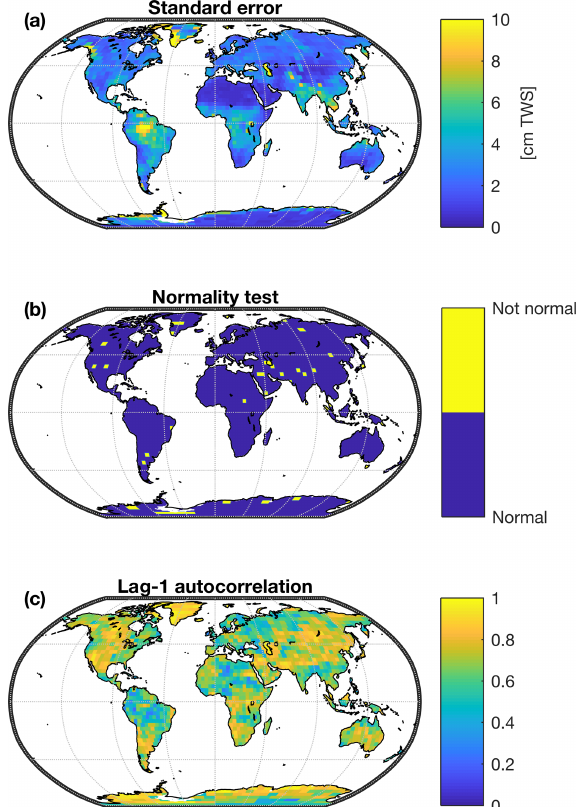
Figure 2. Characterization of the empirical model residuals for the GRACE-REC dataset based on MSWEP precipitation and ERA5 air temperature, calibrated with the JPL mascons. (a) Standard model error. (b) Result of a Kolmogorov–Smirnov test for normality on the model errors ( p < 0 . 05); (c) lag-1 serial autocorrelation of the model